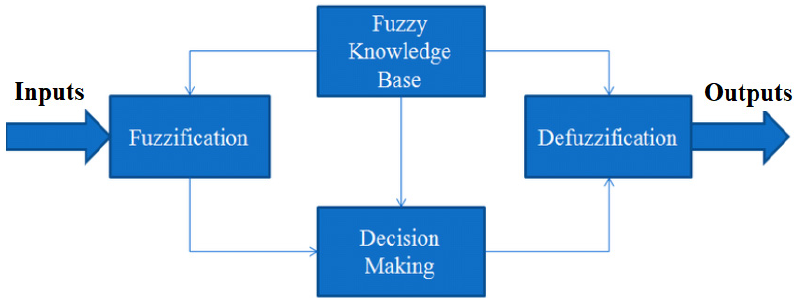
Figure 6. Structure of fuzzy logic controller.